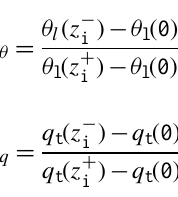
Fig. 7. Time-height section of (top) mixing ratio (gkg − 1 ) and (bottom) potential temperature (K) from the soundings launched at Iquique during